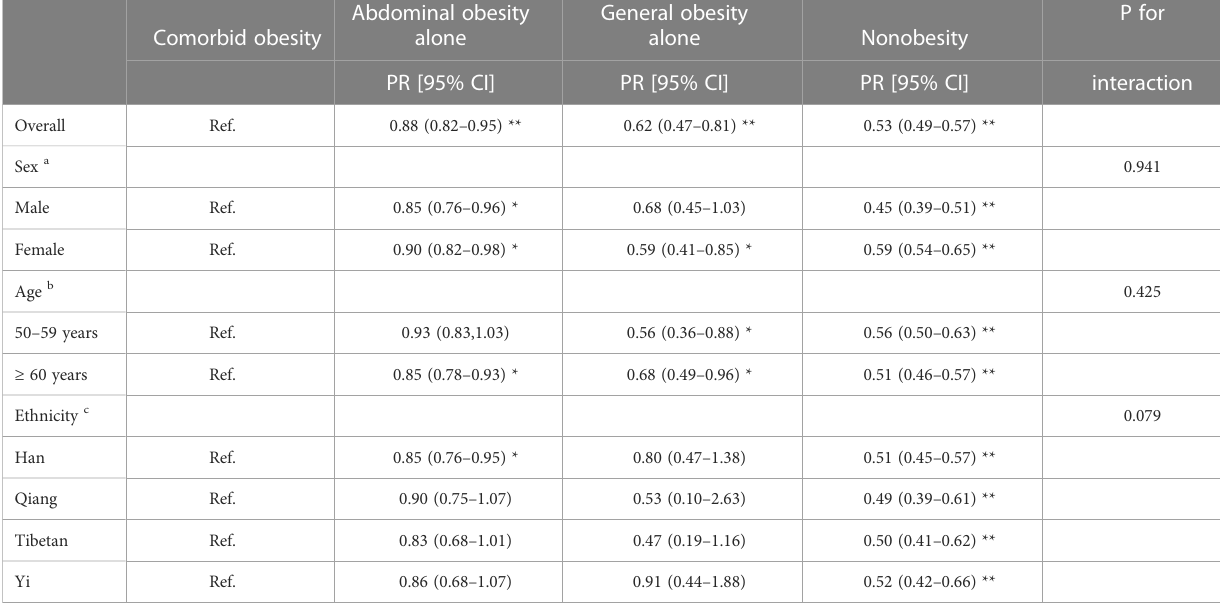
TABLE 5 Associations of obesity subgroups with hypertriglyceridemia in the adjusted model.